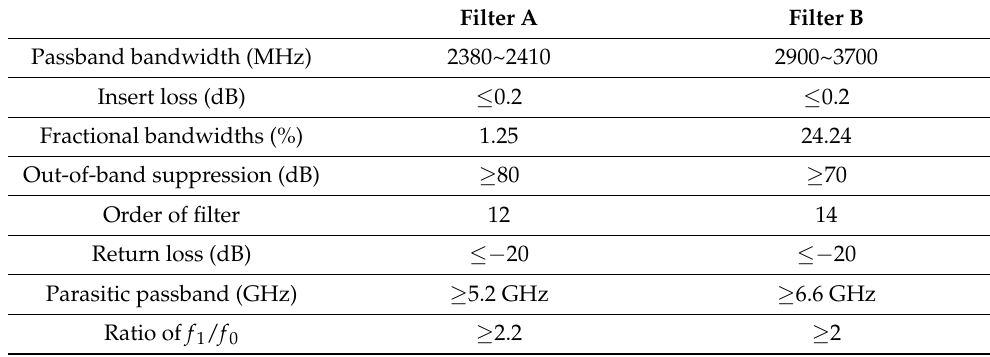
Table 1. Index of the filter.